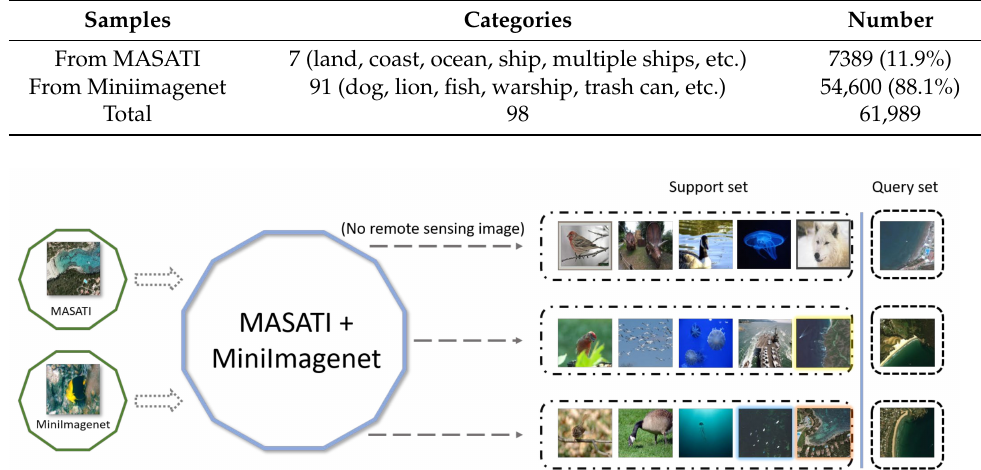
Table 1. Composition of the mixed dataset we designed, including the categories and number of samples from different datasets. The dataset contains a total of 98 categories, a total of 61,989 samples, of which remote sensing image samples account for 11.9%.